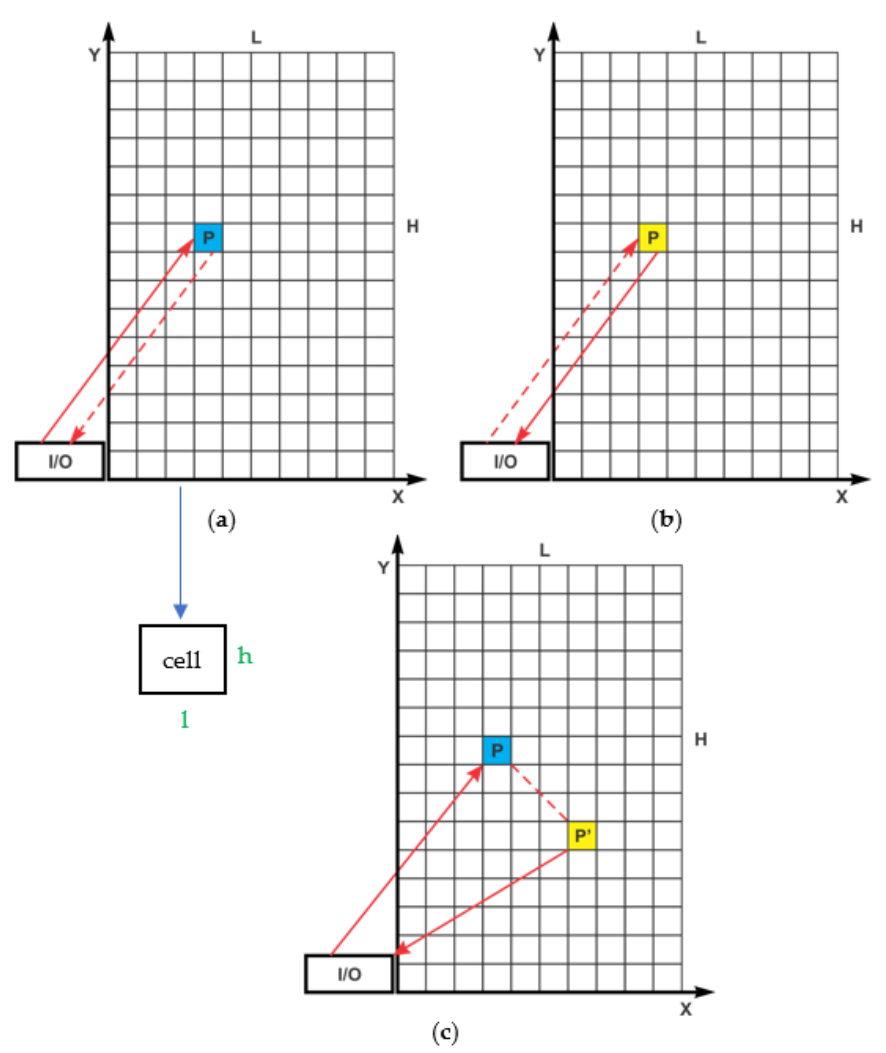
Figure 2. The three operation modes of AS/RS, ( a ) Single command cycle in case of storage, ( b ) Single command cycle in case of retrieval, and ( c ) Duall command cycle.